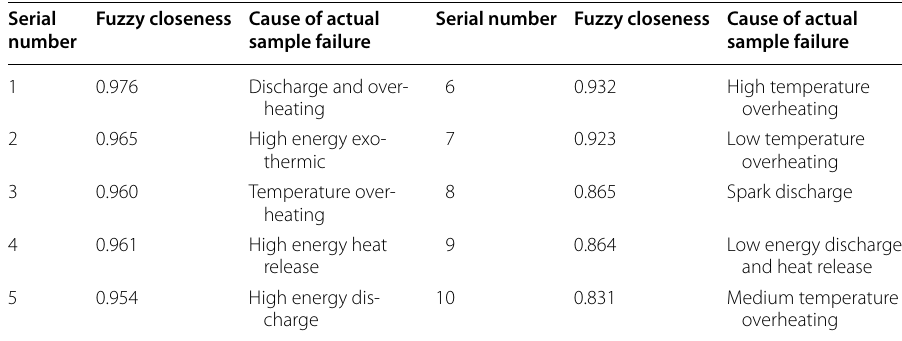
Table 13 Diagnosis results Serial Fuzzy closeness Cause of actual number sample failure